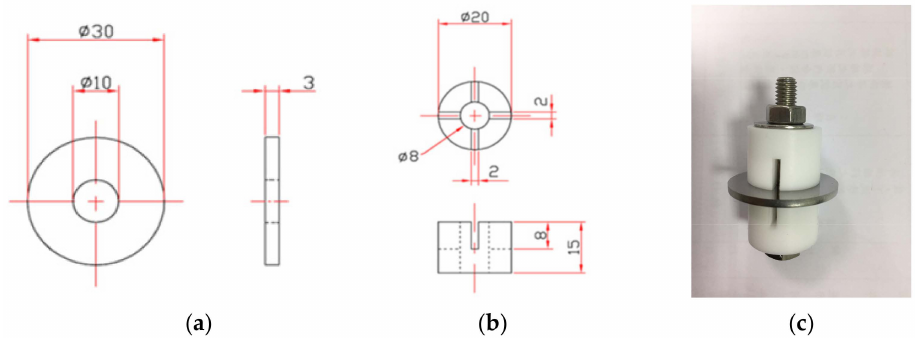
Figure 1. Shape and dimension of specimens used for crevice corrosion test. ( a ) Specimen, ( b ) crevice former, and ( c ) assembled image. (Unit: